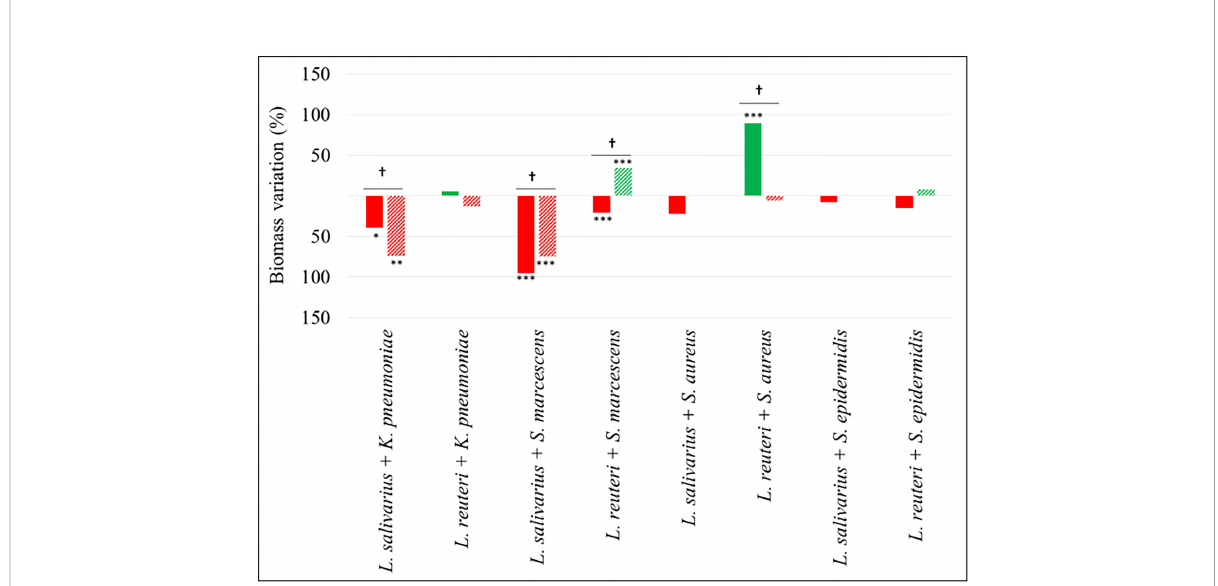
FIGURE 4 Percentage of biomass variation in dual-species bio fi lms. Red and green bars mean biomass reduction and biomass increasing compared with monospecies bio fi lms of the respective pathogenic strains. Filled and lined bars represent 24 h and 48 h samples, respectively. Asterisks show statistical differences between monospecies pathogenic bio fi lms and dual-species bio fi lms with both LAB: * (p < 0.05), ** (p < 0.005) and *** (p < 0.001). † indicate statistical differences between 24 h and 48 h samples